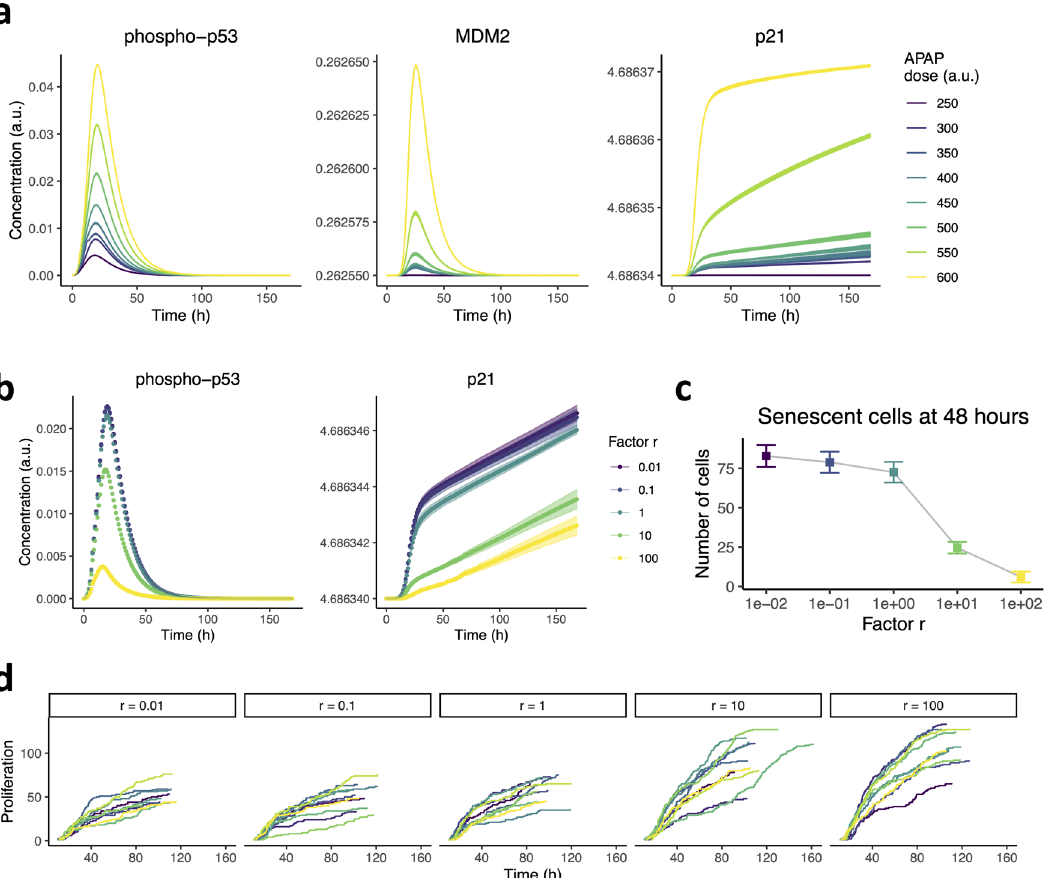
Fig. 4 Suppression of DNA damage signaling increases regeneration capacity after APAP insult. a Protein expression of phospho-p53, MDM2 and p21 over time after exposure to various APAP concentrations. Due to the deterministic character of the intracellular dynamics, there is very little variation between different simulations per condition. b Protein expression of phospho-p53 and p21 over time under different feedback strengths of MDM2 on p53 after exposure to 500 APAP. Factor r is the multiplication factor used to scale the MDM2 feedback on p53 and phospho-p53 up or down. Due to the deterministic character of the intracellular dynamics, there is only little variation between different simulations per condition. c , d The number of senescent cells at 48 h ( c ) and cumulative hepatocyte proliferation events ( d ) after 500 APAP exposure at different MDM2-p53 feedback strengths. Results are based on ten simulations per condition represented as mean ± sd. a.u., arbitrary